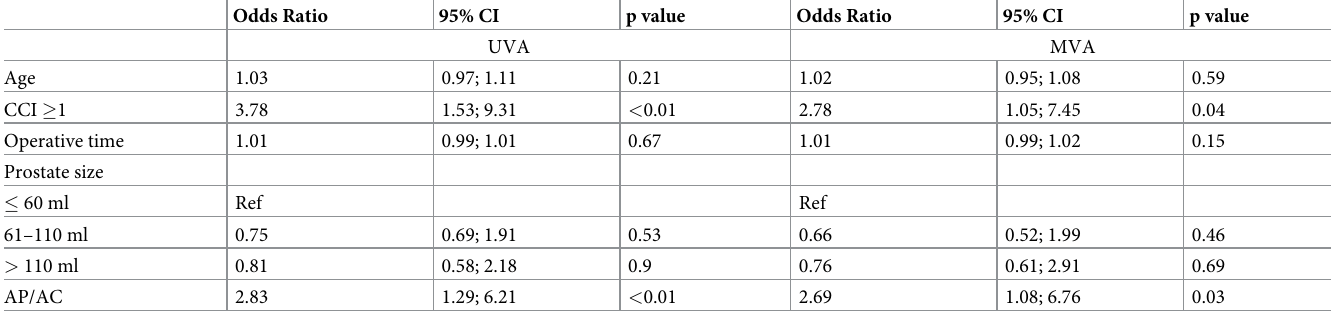
Table 5. Univariable and multivariable logistic regression models predicting postoperative complications (any) after